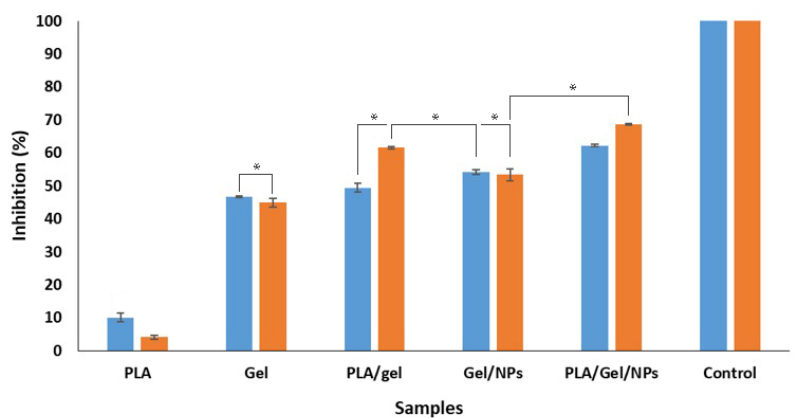
Figure 9. Quantitative antibacterial activity of different synthesized mats on E. coli (blue) and S. aureus (orange). Control: Bacteria and culture media without any textiles. The experiments were repeated in triplicate. Asterisks indicate statistically significant differences using Duncan’s test (* p <